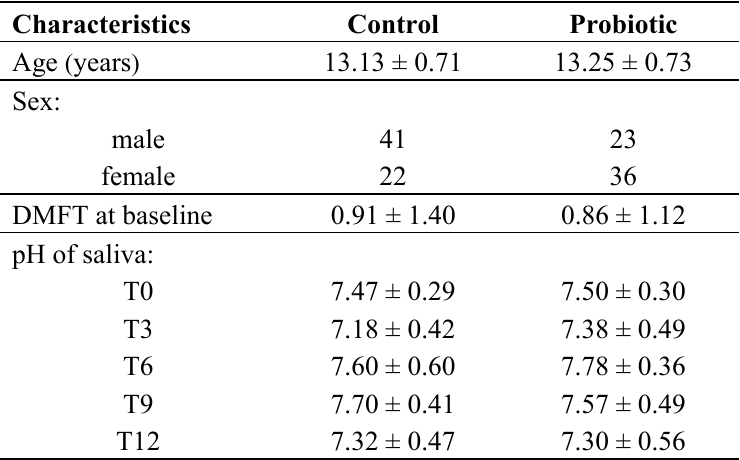
Table 1. General characteristics of